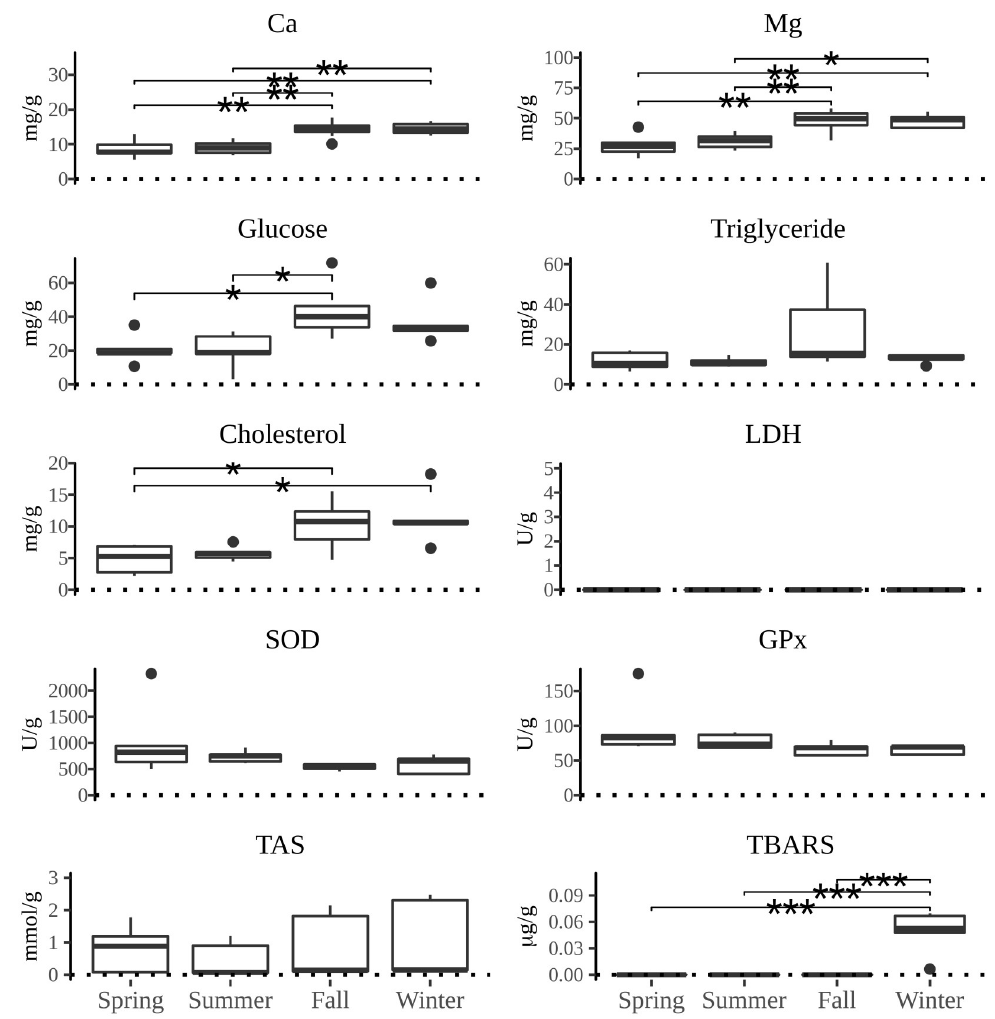
Fig 4. The boxplot distribution of biochemical parameters in gills of Pecten jacobeus between seasons of the year. The lines above boxplots show the significance level ( � p < 0.05, �� p < 0.01, ��� p < 0.001) of differences between seasons in the pairwise comparison. The endpoints of the lines mark two seasons with significant